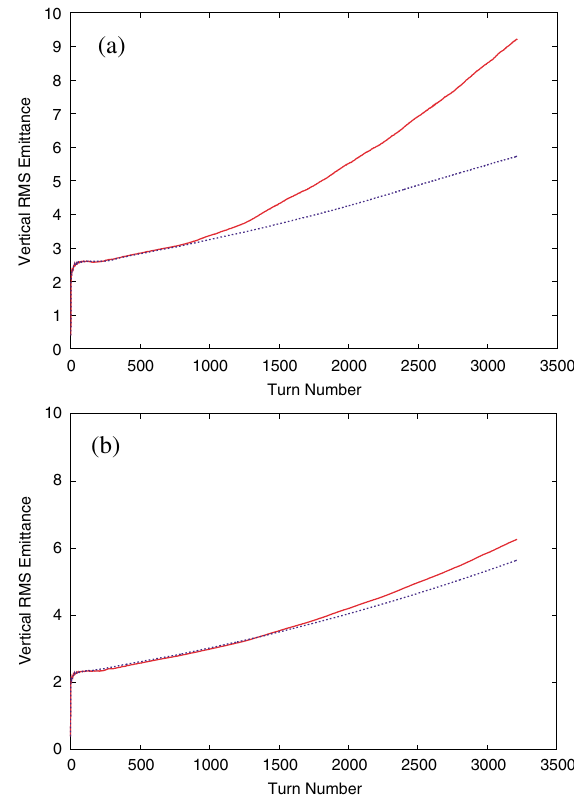
FIG. 27. (Color) Top panel: Vertical rms emittance versus turn number during the accumulation of a high intensity beam in the real PSR lattice. Bottom panel: Vertical rms emittance versus turn number during the accumulation of a high intensity beam in the symmetric PSR-like lattice. In both plots, the solid (red) curves represent the beam with space charge, and the dashed (blue) curves represent the beam without space charge.